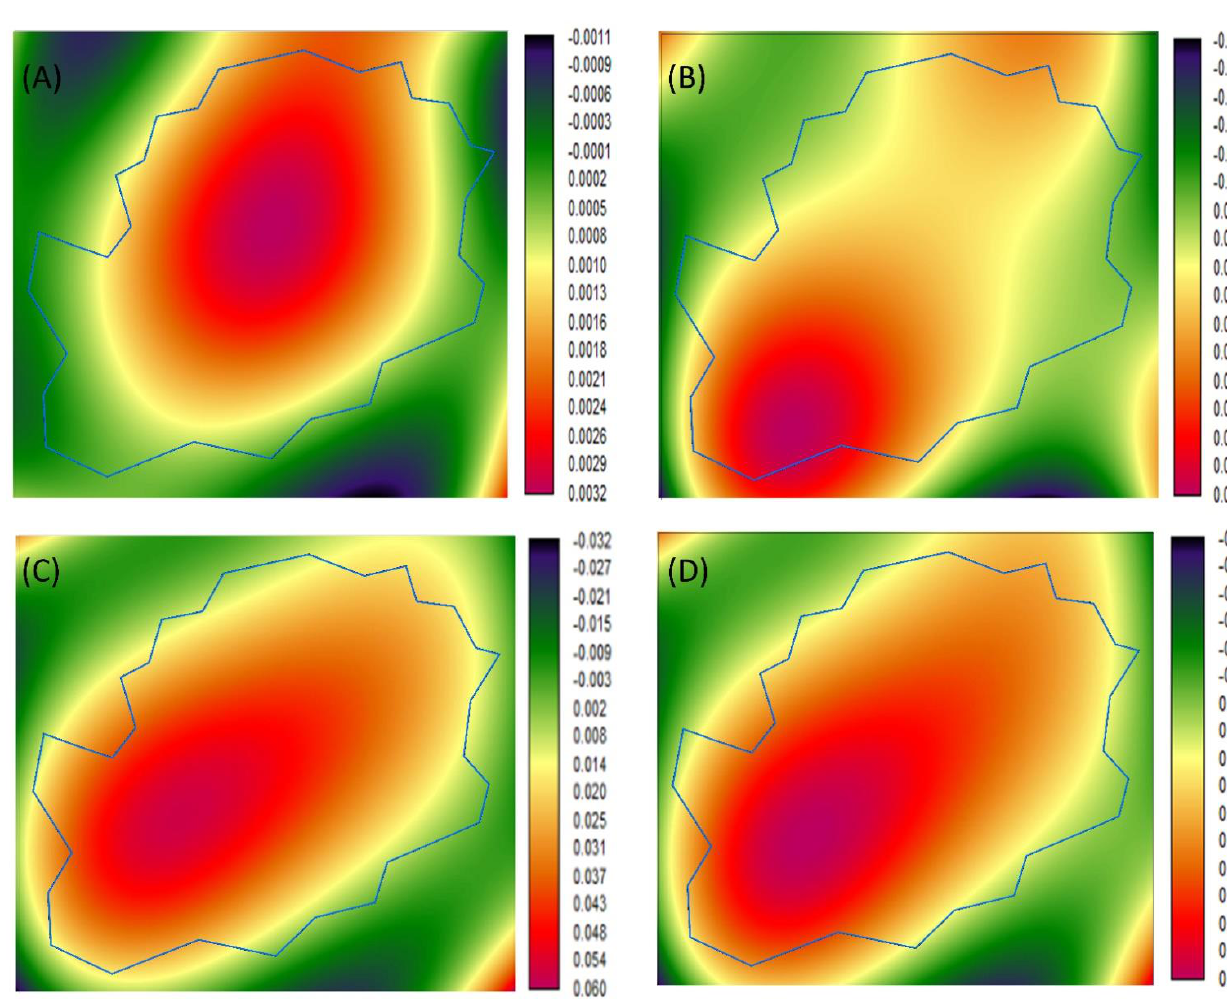
Figure 9. Spatial trend surface (4th-order trend) of LULC dynamics in 2030: vegetation to urban ( A ); bare land to urban; ( B ) desert to urban; ( C ) all land types to urban ( D ).